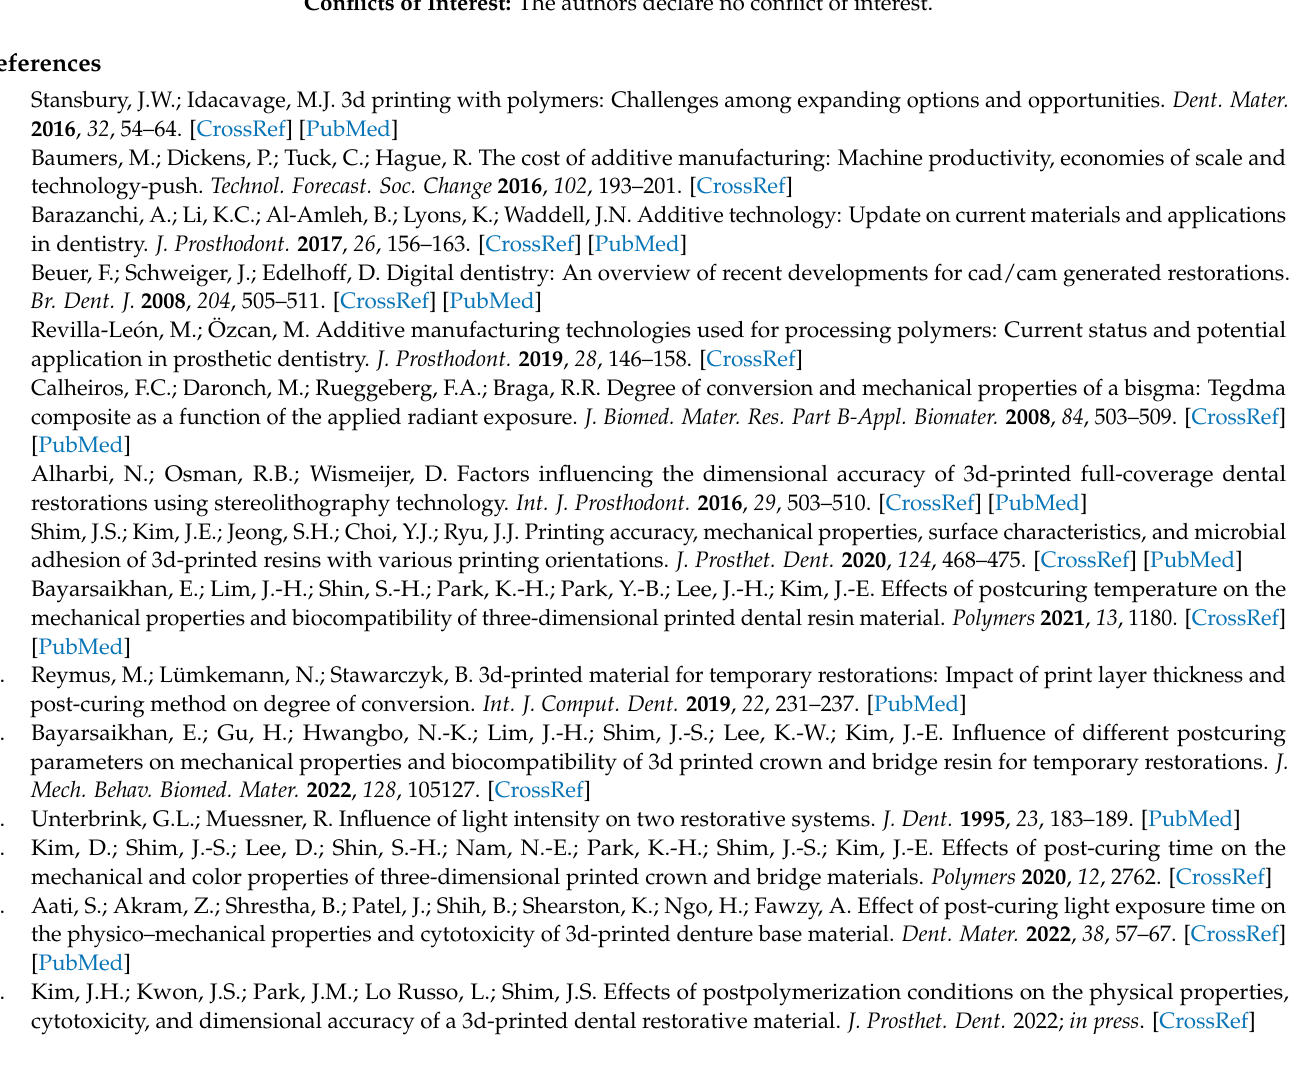
and modulus; Table S2: Mean ± SD values on Vickers microhardness; Table S3: Mean ± SD RMSE values on accuracy of the three-unit